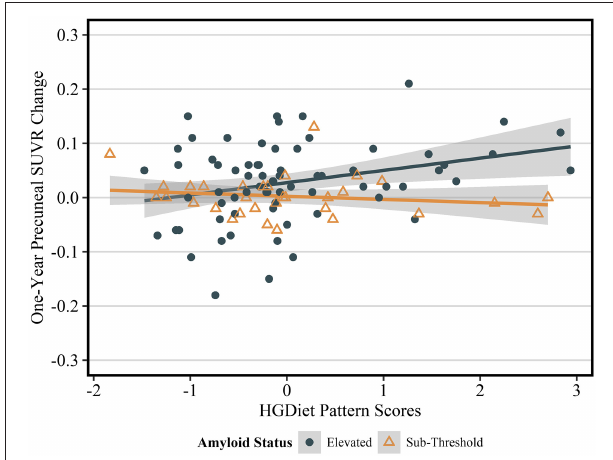
FIGURE 5 | Sensitivity analysis of relationship between HGDiet pattern and 1-year change in precuneal amyloid stratified by baseline amyloid status. The relationship between HGDiet pattern scores and 1-year amyloid aggregation was strongest in the precuneus and accentuated in participants with elevated amyloid at baseline the ( β = 0.40, p = 0.002). Beta- and p -values from ordinary least squares regression models were adjusted for age, sex, group assignment, APOE status, baseline BMI, and baseline precuneal SUVR value. Shaded areas are 95% confidence intervals. The relationship between HGDiet pattern scores and 1-year change in SUVR values was also accentuated in the lateral temporal lobe ( β = 0.29, p = 0.02), posterior cingulate ( β = 0.25, p = 0.03), and globally ( β = 0.23, p =